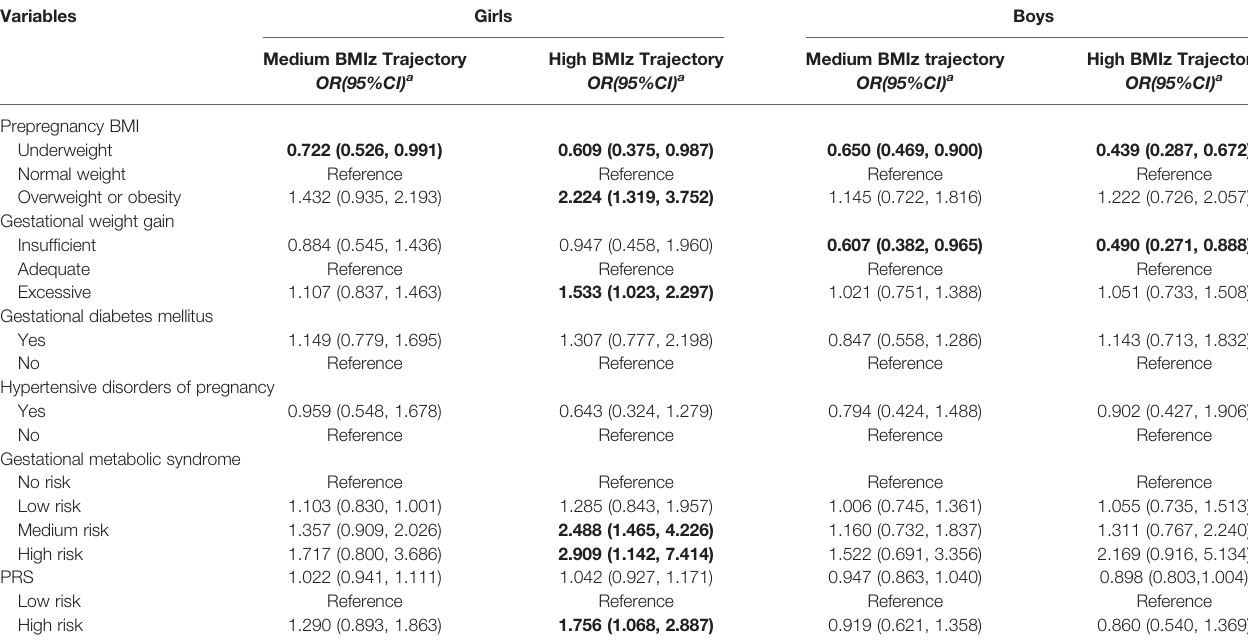
TABLE 4 | Association of gestational metabolic syndrome parameters with children ’ s BMIz score trajectory